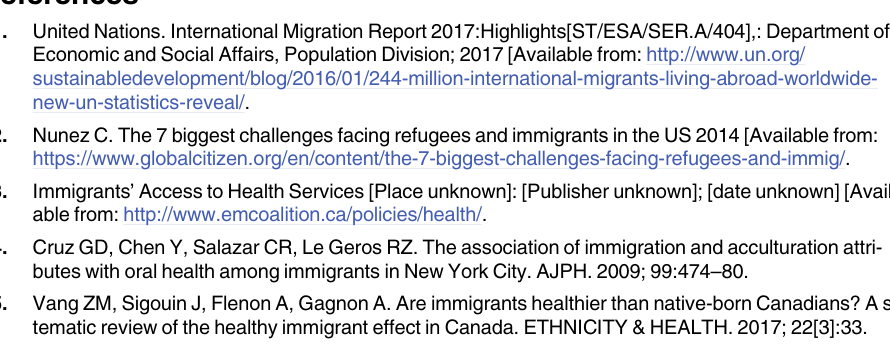
S1 Table. Search strategy and results from different electronic